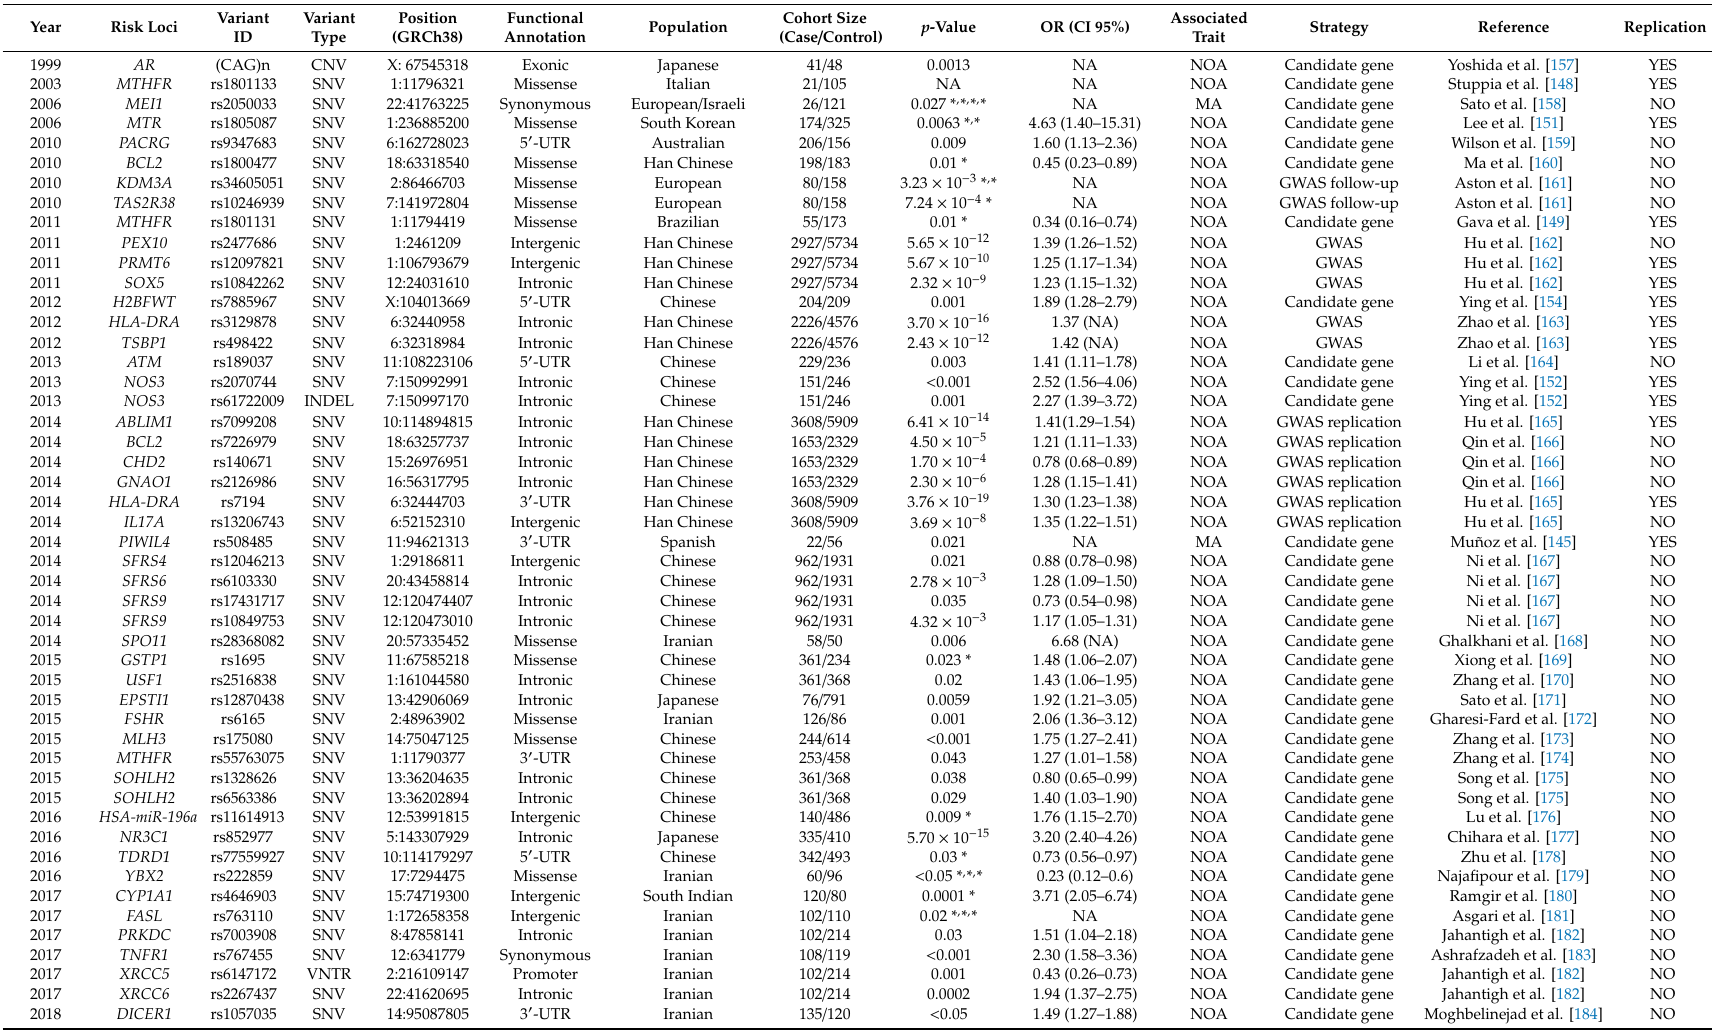
Table 1. Common genetic variations associated with nonobstructive azoospermia through association